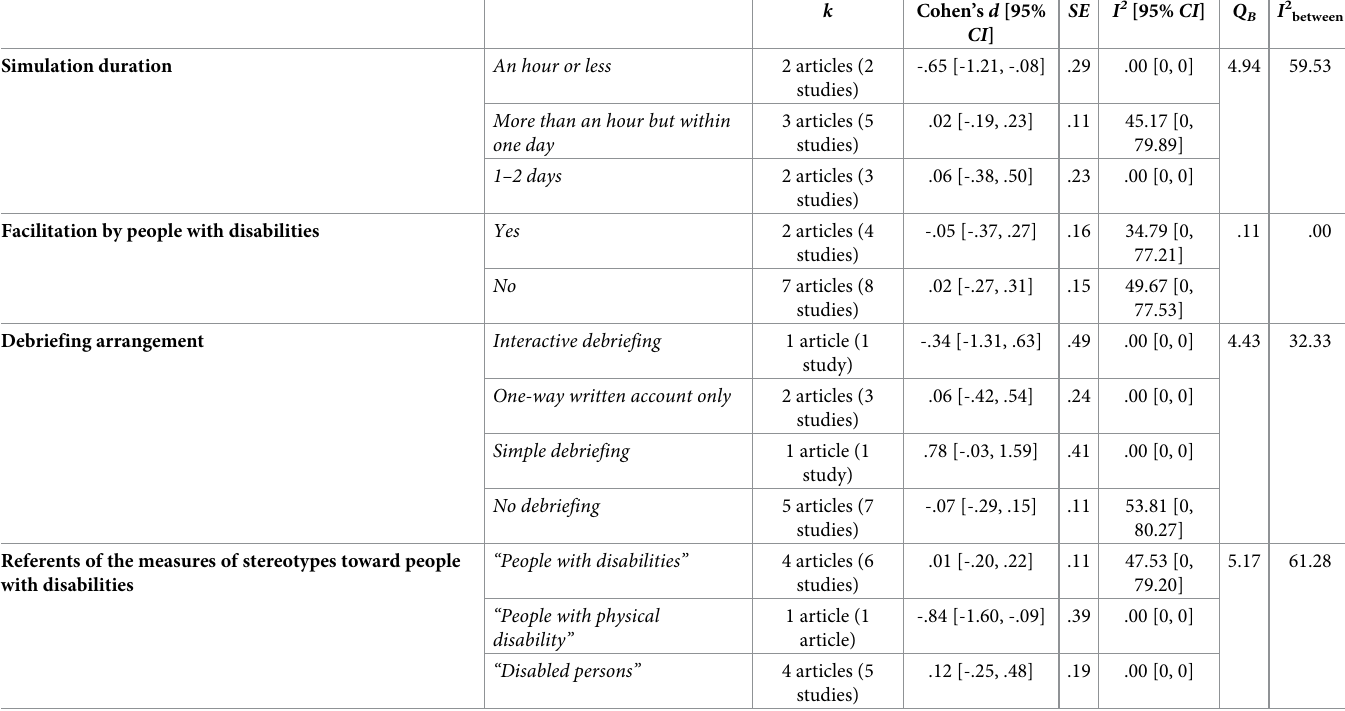
Table 2. Results of subgroup analyses on pre-post effects on stereotypes toward people with